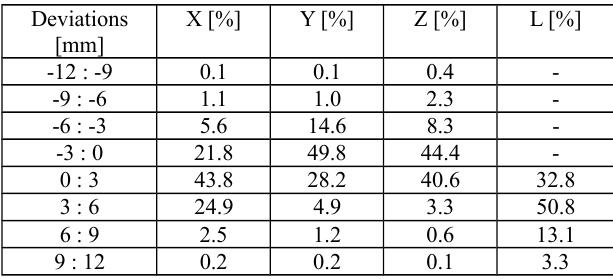
Table 3. Percentage number of points for specified deviations - test filed